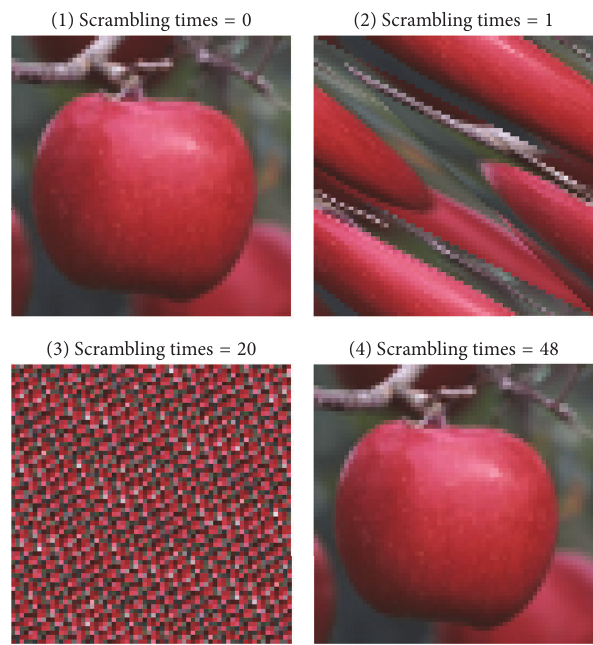
Figure 1: Arnold